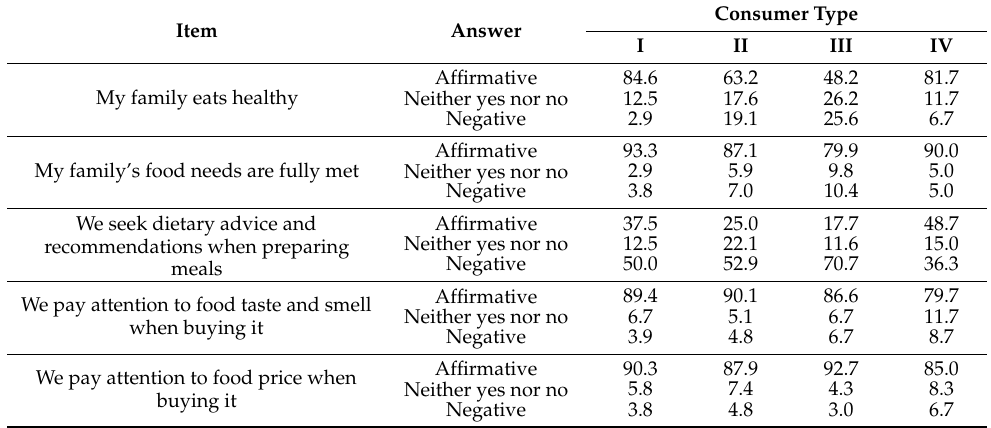
Table 5. Opinions of Polish consumers on food and nutrition ( n = 600, in %).